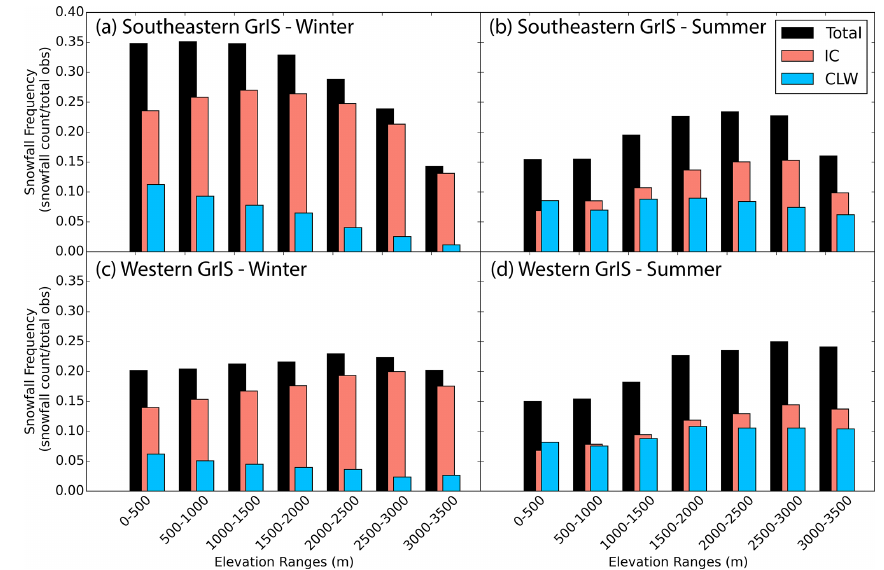
Figure 3. Snowfall frequency partitioned by elevation for (a) winter (October–April) in the southeastern GrIS (basins 3.3, 4.1, 4.2, 4.3, and 5.0 in Fig. 1), (b) summer (May–September) in the southeastern GrIS, (c) winter in the western GrIS (basins 6.1, 6.2, 7.1, 7.2, 8.1, and 8.2), and (d) summer in the western GrIS. Frequency is determined by dividing the number of snowfall observations by the total number of observations for a given elevation range. Black bars include all observed snowfall, red bars include IC events only, and blue bars include CLW events